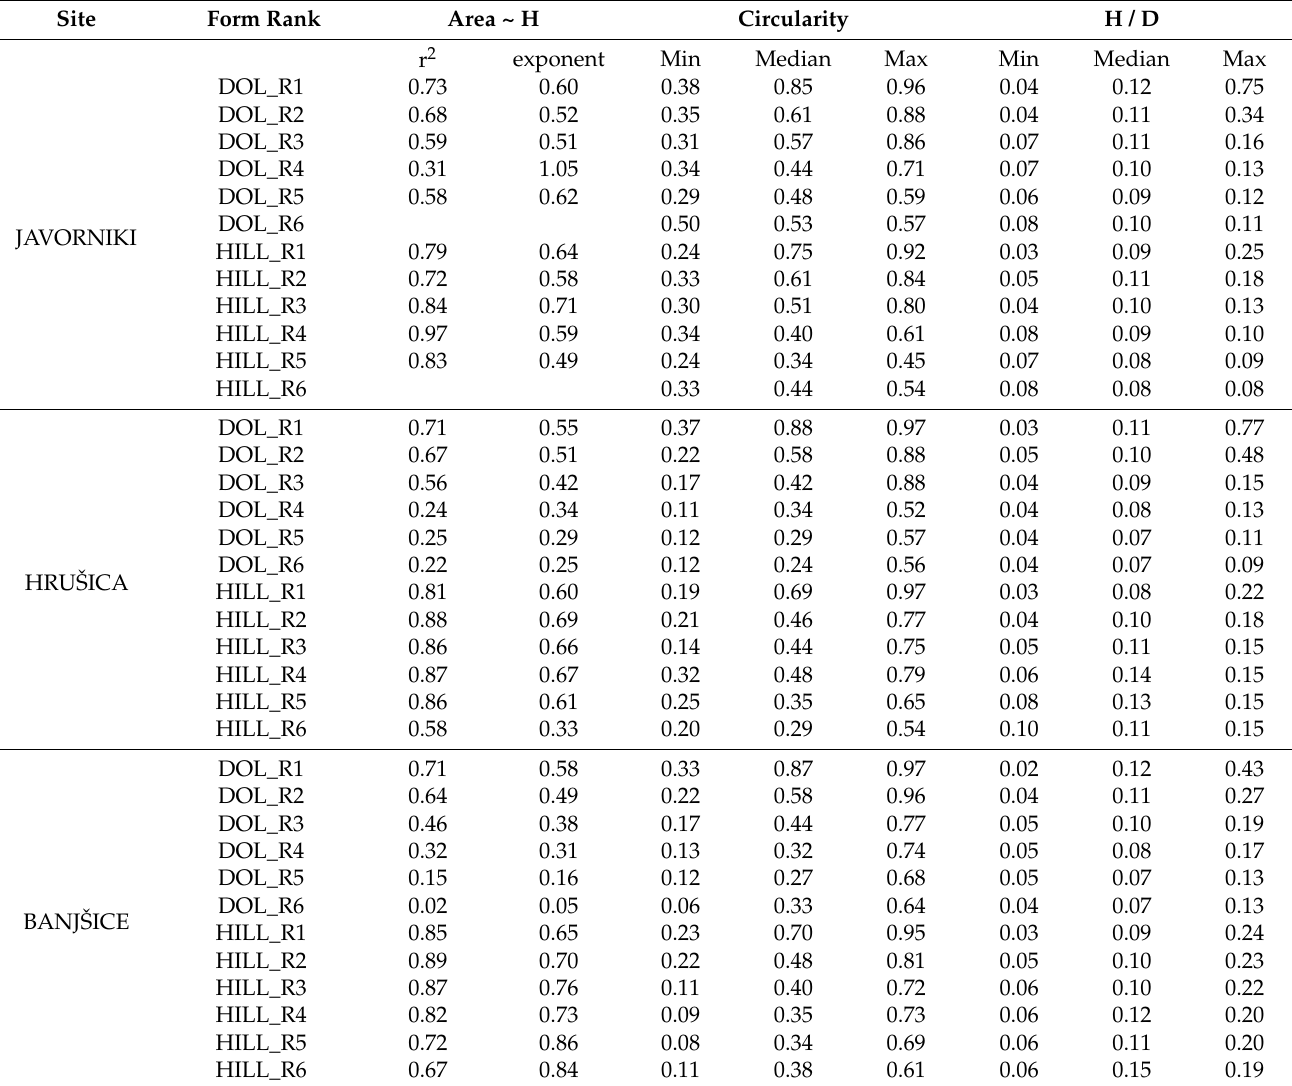
Table 2. Morphometric parameters (A ~ H, circularity, H / D) of dolines and hills of the study areas. A: Area, H: vertical range (depth for dolines, height for cones), and D: equivalent diameter.